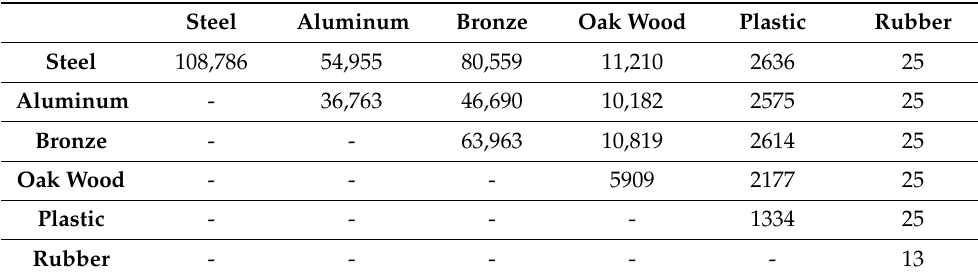
Table 2. RecurDyn stiffness contact coefficient